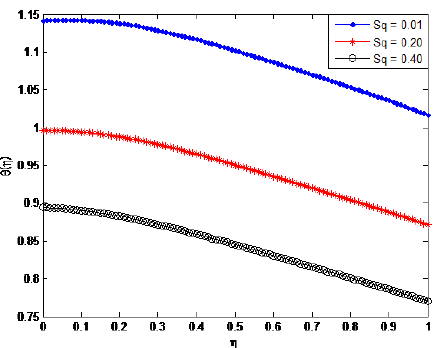
Figure 3. Influence of squeezing parameter on dimensionless